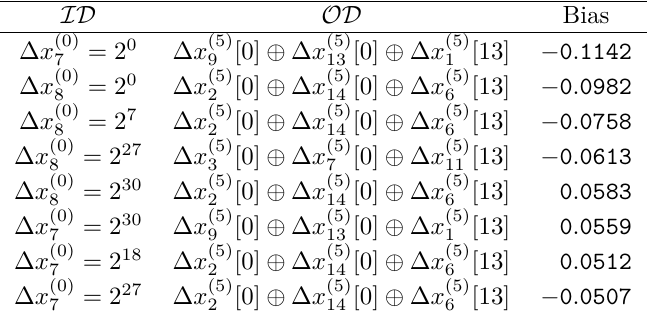
Table 3: Best triple bit differentials for 5 rounds of